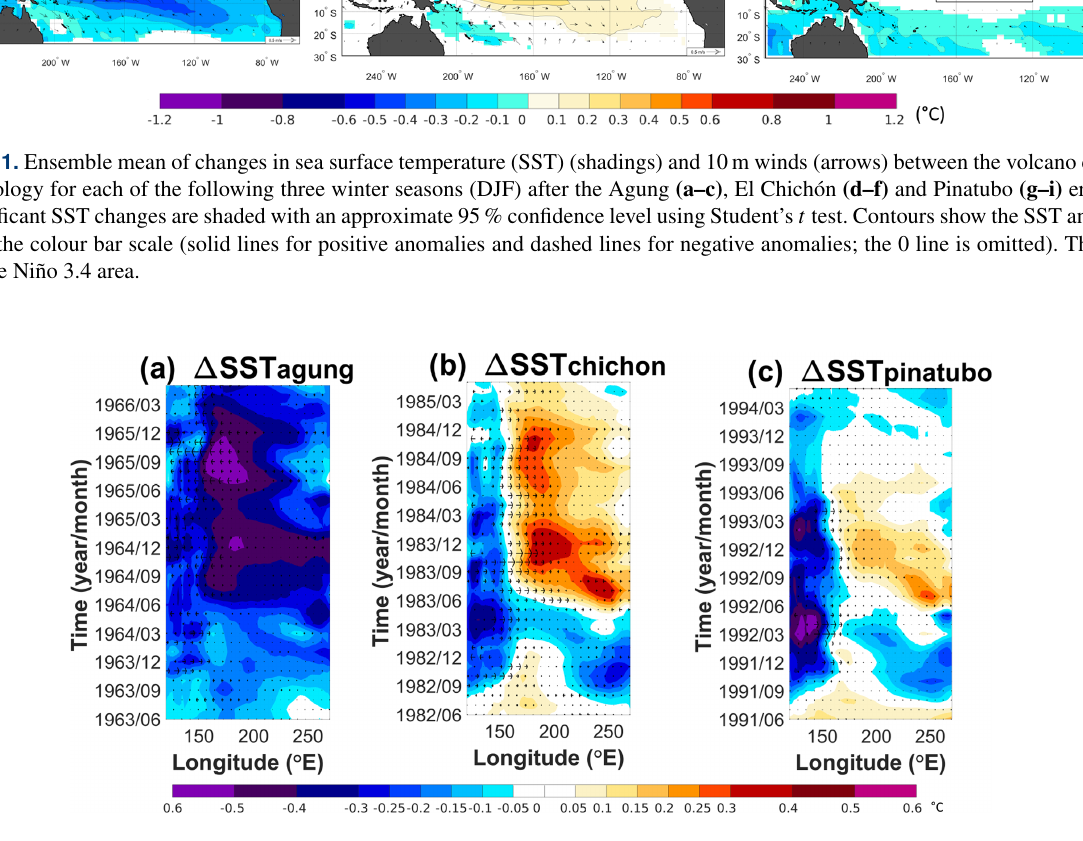
Figure A12. Hovmöller plot of the ensemble mean of the SST anomalies in the equatorial Pacific (averaged over − 5 and 5 ◦ N) and the change in the zonal component of the 10m winds (m/s) for the 3 years following each eruption. The anomalies are calculated relative to the 3 years before each